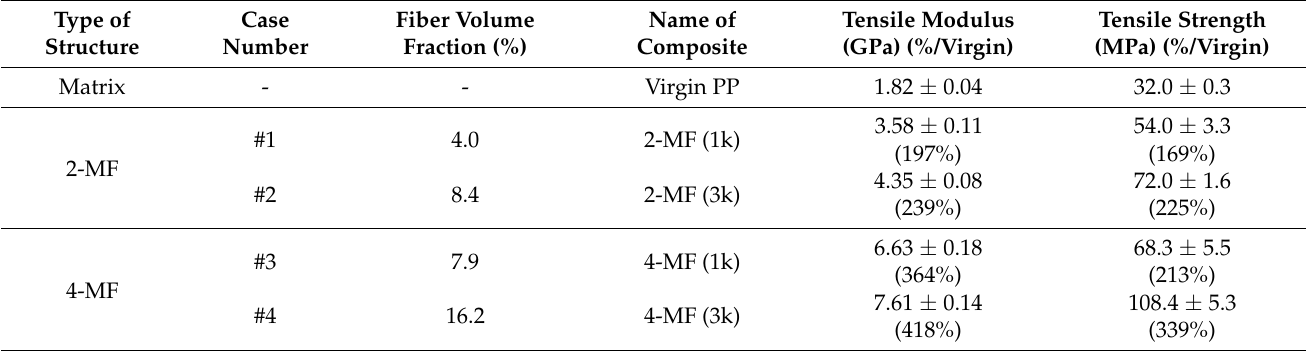
Figure 10. Results of the tensile tests of mesh-inserted composites: ( a ) direction of loading; ( b ) cross- section images of composites; ( c ) stress – strain curves of composites and virgin matrix.